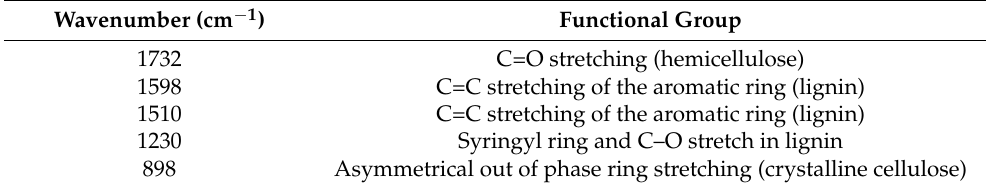
Table 3. Characteristic IR bands of samples studied in the fingerprint